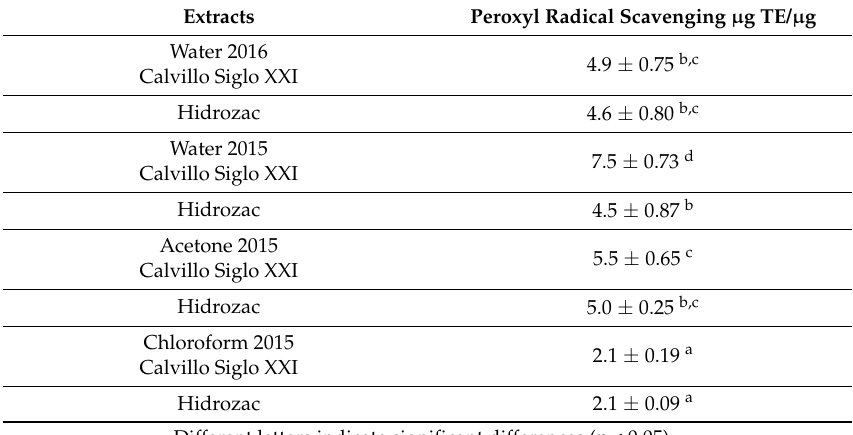
Table 6. Peroxyl radical scavenging ability in aqueous, acetone, and chloroform extracts of the leaves of Calvillo Siglo XXI and Hidrozac. The average values ( ± SD) are expressed as micromoles trolox equivalents per microgram of extract ( µ M TE/ µ